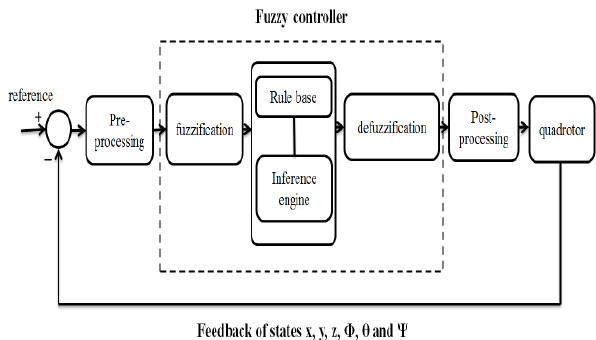
Figure 3. Control strategy [23].